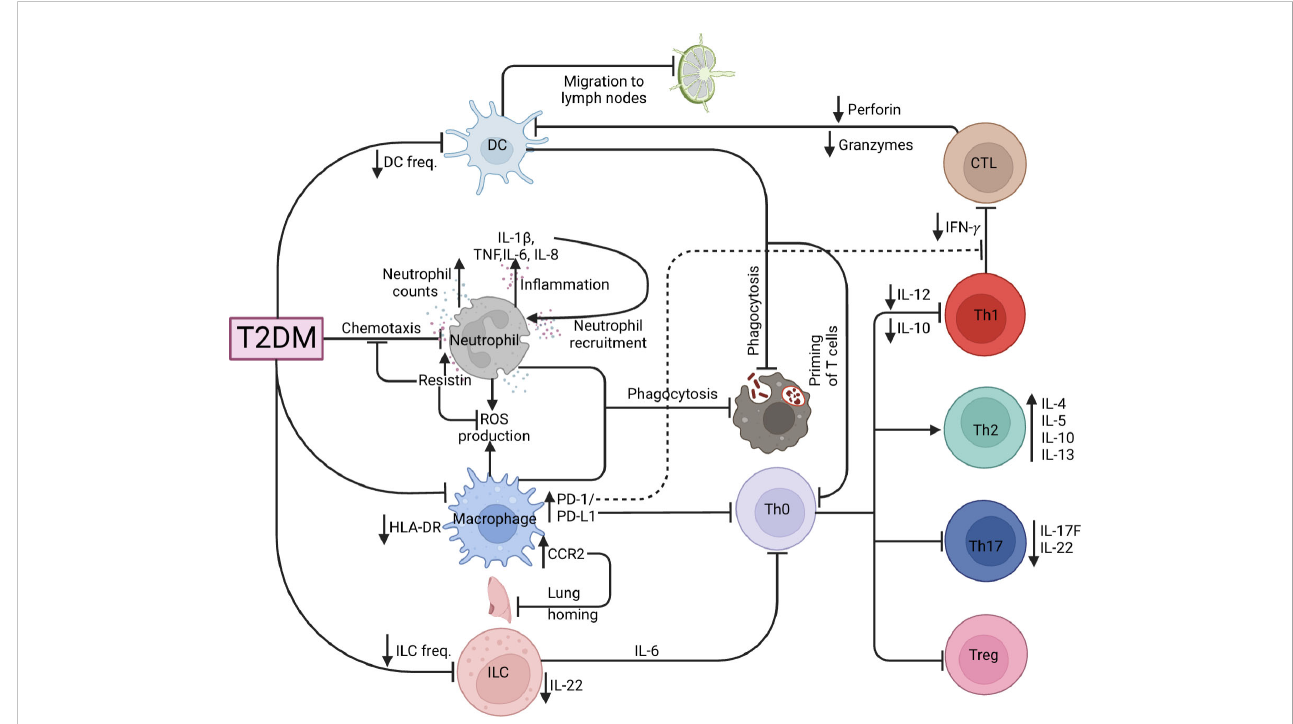
FIGURE 3 TB and T2DM immunological dysregulation. Effects of T2DM on the various innate (DC, neutrophil, macrophage, ILC) and adaptive (CTL, Th1, Th2, Th17 and Tregs) immune